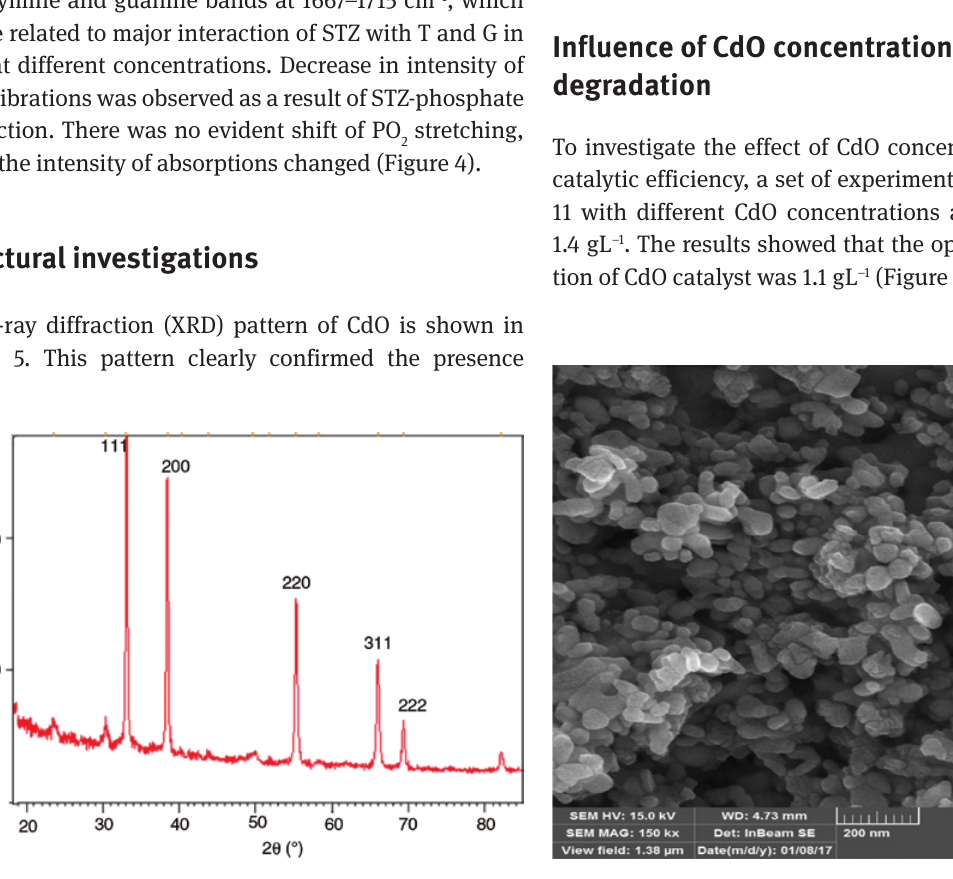
Figure 5: XRD pattern of CdO nanoparticles. Figure 6: SEM image of CdO